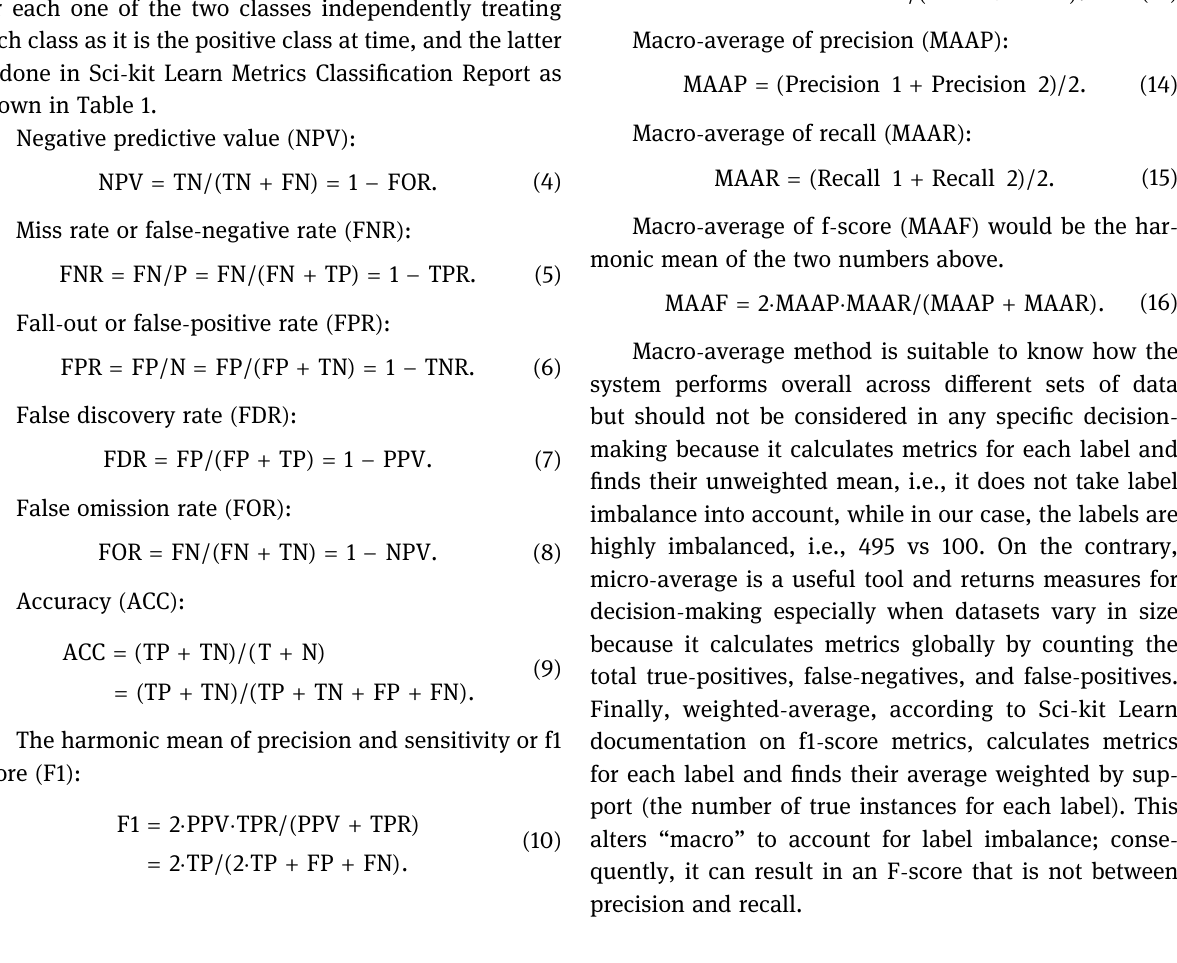
Table 1: Classi fi cation report